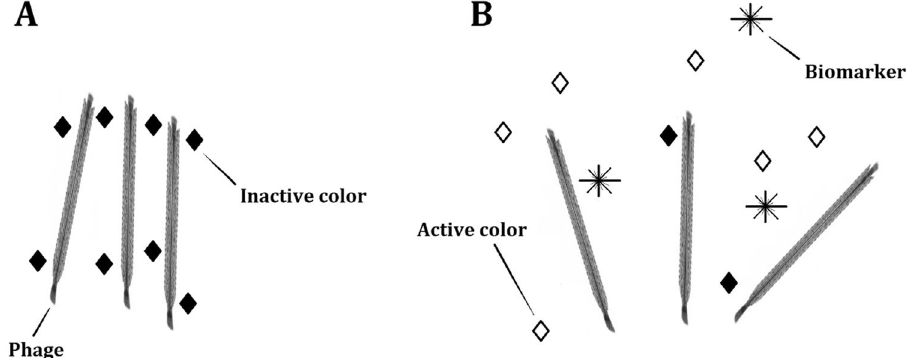
Figure 3. Possible reaction mechanisms for dye and biomarker binding to the network of specific phages. In the left side of the figure, the biomarker is not present and the phages are organized along dye molecules. The right side of the figure shows the displacement of dyes from the vicinity of the phages ( A ). Another possibility is the direct interaction of dye-phage complexes to the biomarkers ( B